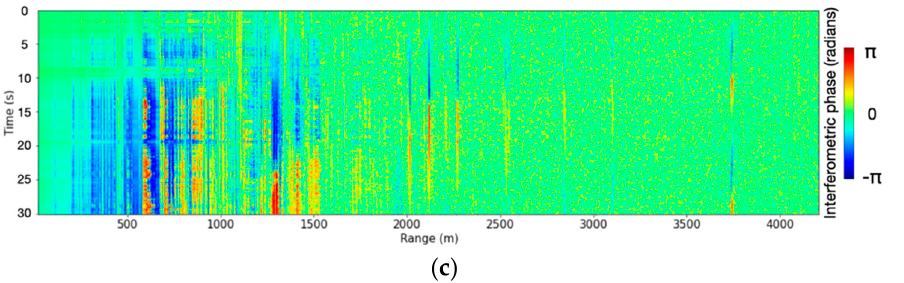
Figure 7. Stare-mode acquisition acquired 4 March 2020 and derived backscatter ( a ), coherence ( b ) and interferometric phase ( c ). Strong scatterers s5–s7 can be identified in ( a ). σ 0 is not calculated in ( a ) as absolute calibration was not performed. The authors apologize for any inconvenience caused and state that the scientific conclusions are unaffected. The original article has been updated.